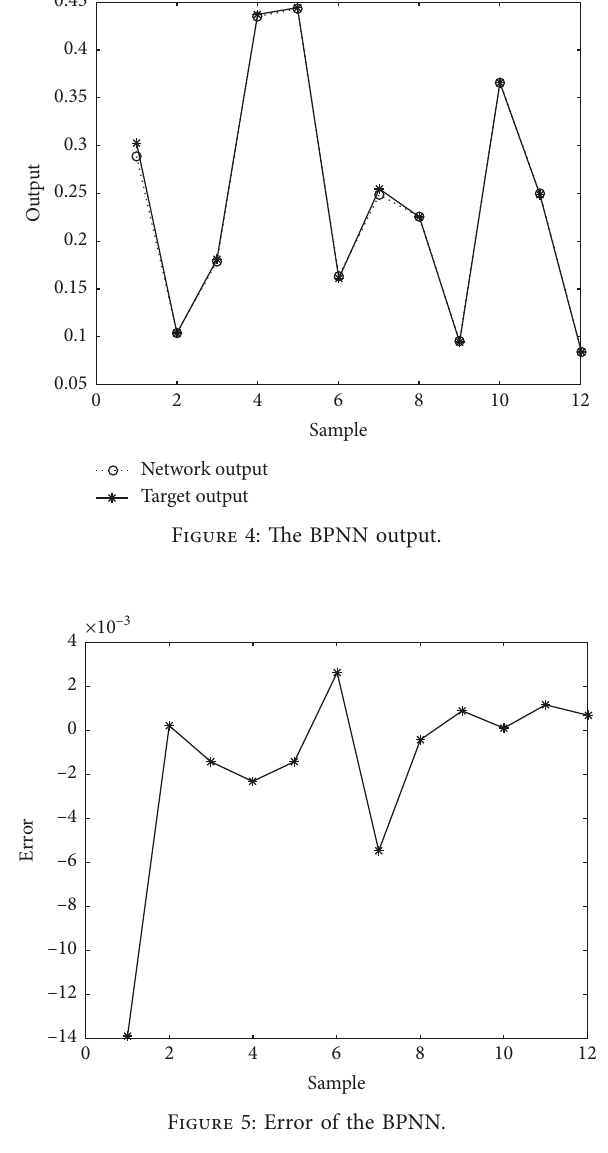
Figure 5: Error of the BPNN.